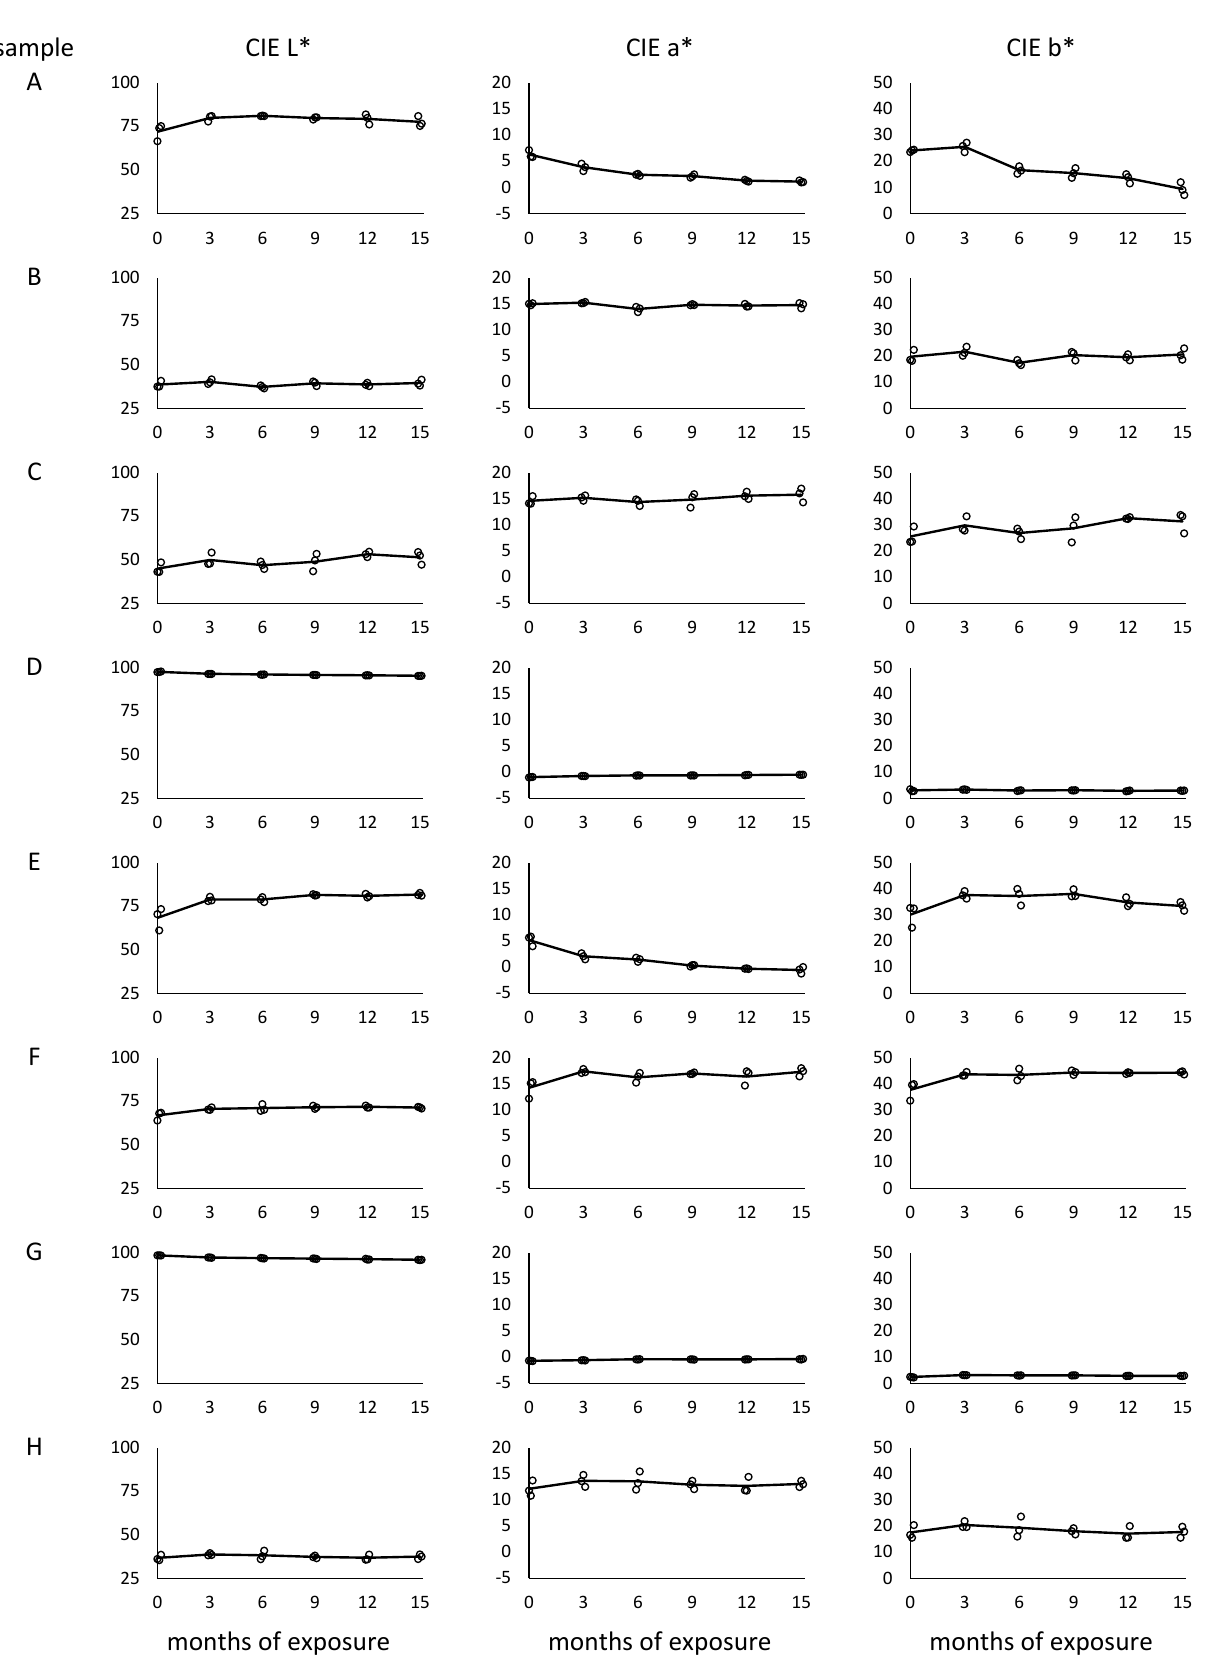
Figure 2. Colour changes of acetylated wood samples exposed to natural weathering. A–H: sample